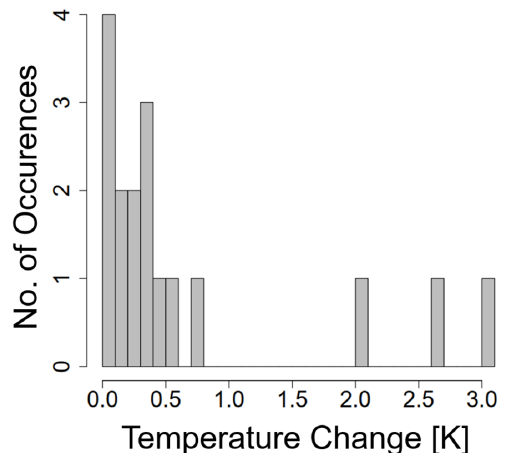
Figure 6. Histogram of temperature change resulting from the ob- served turbulence events assuming isobaric heating and full conver- sion into